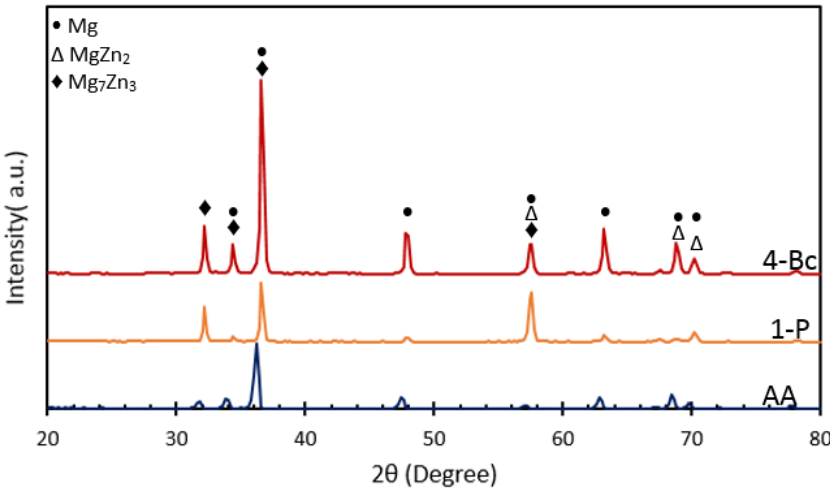
Figure 3. XRD pattern diffractions of the ZK30 alloy before and after ECAP processing through 1-P, and 4-Bc.